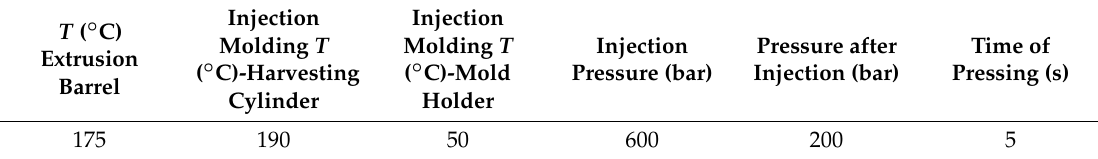
Table 1. Laboratory scale microextruder and mini-injection molding processing